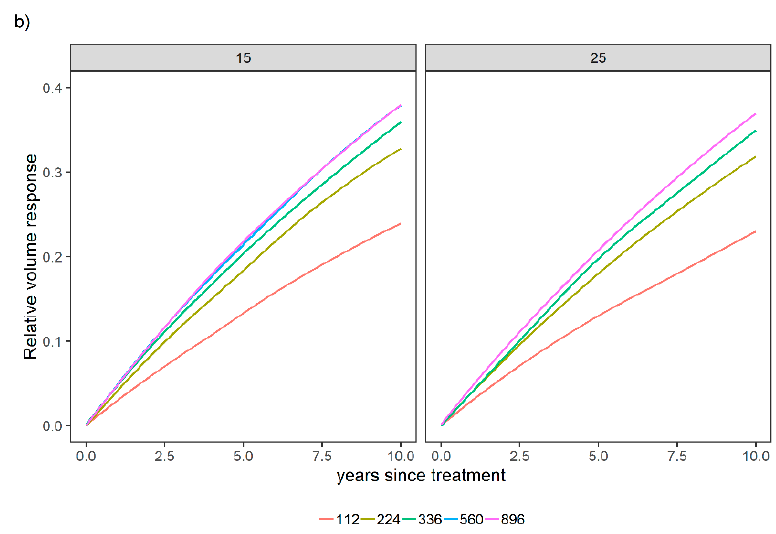
Figure 8. Relative stand-level volume response for two initial site index scenarios [15 m and 25 m] across different levels of N (112, 224, 336, 560, and 896 kg ha − 1 ) over time (years since treatment was established) when P was not applied ( a ) or when 28 kg ha − 1 of P was applied ( b ). Relative spacing was held constant (RS = 0.20).